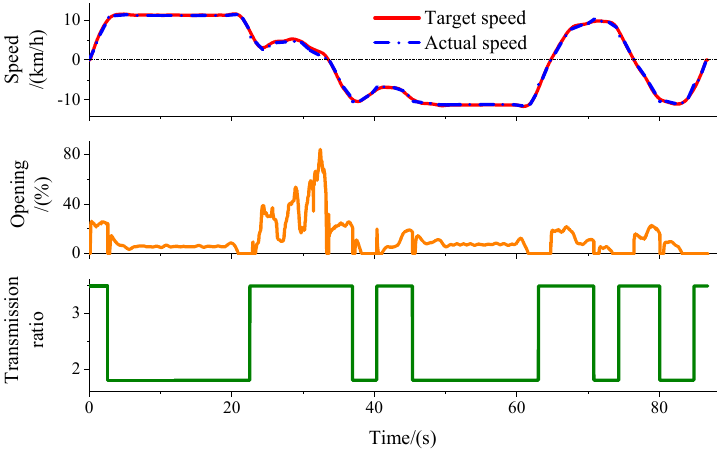
Figure 23. The simulation results of the shift rule under the “V” cycle condition.